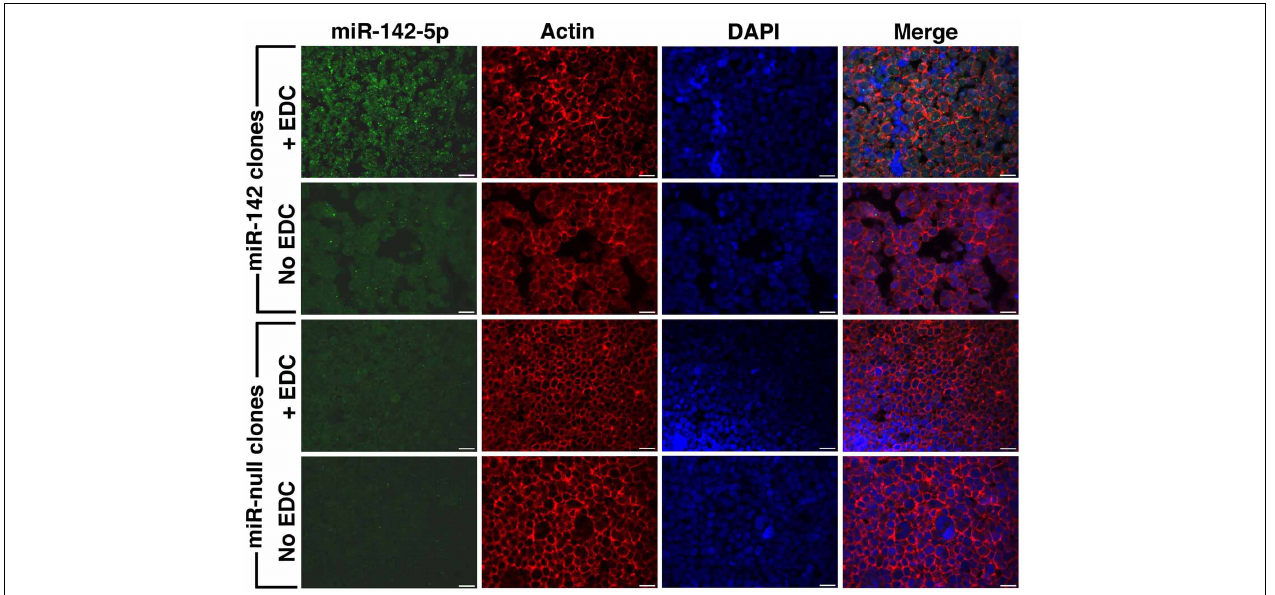
FIGURE 2 | Post-fixation with EDC improves FISH signal. Combined FISH and IF was performed for miRNA-142-5p and actin in FFPE sections of BE(2)M17 stable clones that express miRNA-142 and those that were transfected with a control plasmid miRNA-null. After post-fixation with EDC,